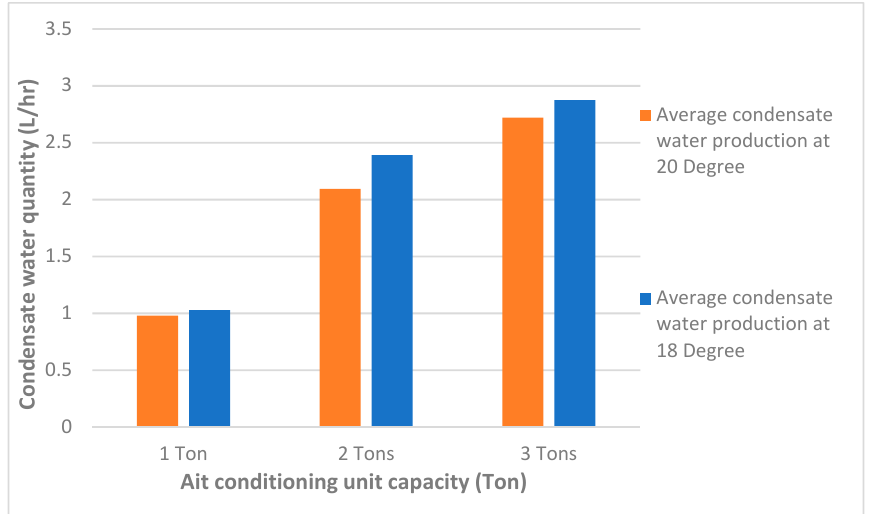
Figure 6. Quantities of condensate water at both 18 °C and 20 °C operating temperatures in Jericho city.